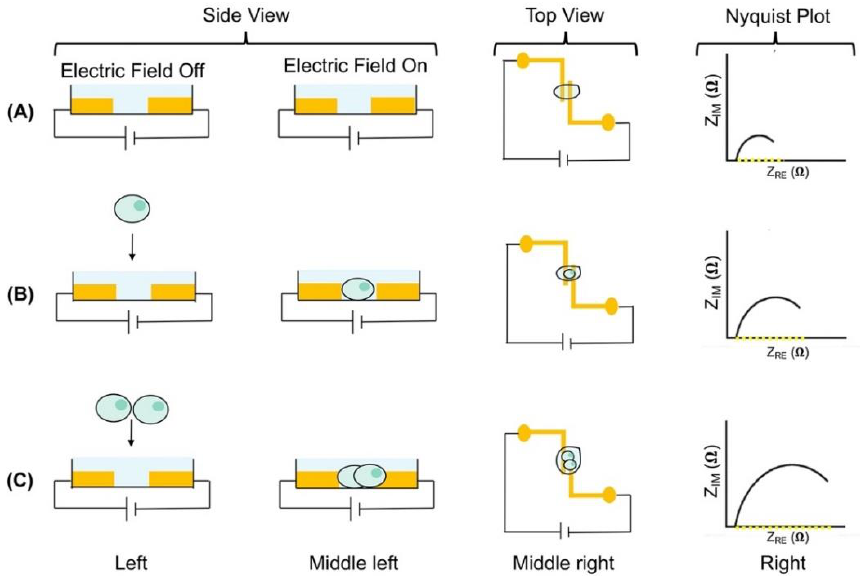
Figure 4. Schematic representation of cell trapping due to electric field polarization for impedance measurements. ( A ) A microfluidic device and conductive medium with the electric field o ff (left) and the electric field on (middle left). Top view of parallel electrodes with no cells (middle right) yielding lower impedance indicated in Nyquist plot (right). ( B ) A cell placed in the device with the electric field o ff results in no polarization (left) and with the electric field on polarization occurs and the cell traps between the electrodes (middle left). Top view of parallel electrodes with a cell (middle right) yielding higher impedance indicated in Nyquist plot (right). ( C ) Two cells placed in the device with the electric field o ff results in no polarization (left) and with the electric field on cells polarize and trap between the electrodes (middle left). Top view of parallel electrodes with the two cells (middle right). Impedance increased due to the presence of two cells indicated in Nyquist plot (right). The impedance with the electric field o ff is shown on Nyquist plots with yellow dotted line. Electrodes colored dark yellow. Light green circles represent cells and the dark green circles are the nuclei.